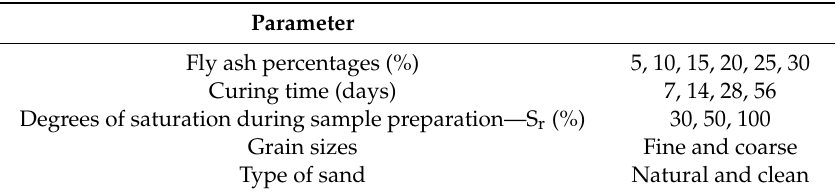
Table 3. The reviewed parameters.